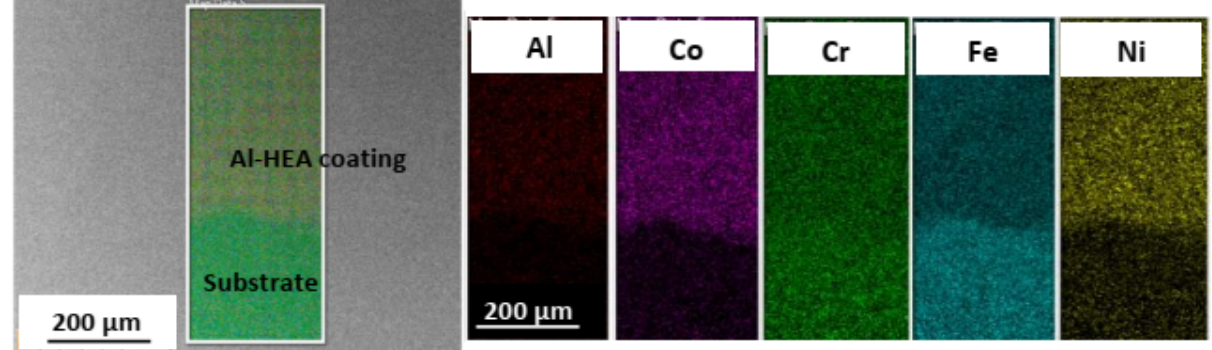
Figure 6. ( i ) A high number of pores was observed in the Mo-HEA coating at the substrate but ( ii ) at a lower frequency and larger volumes in the bulk coating and closer to the surface.